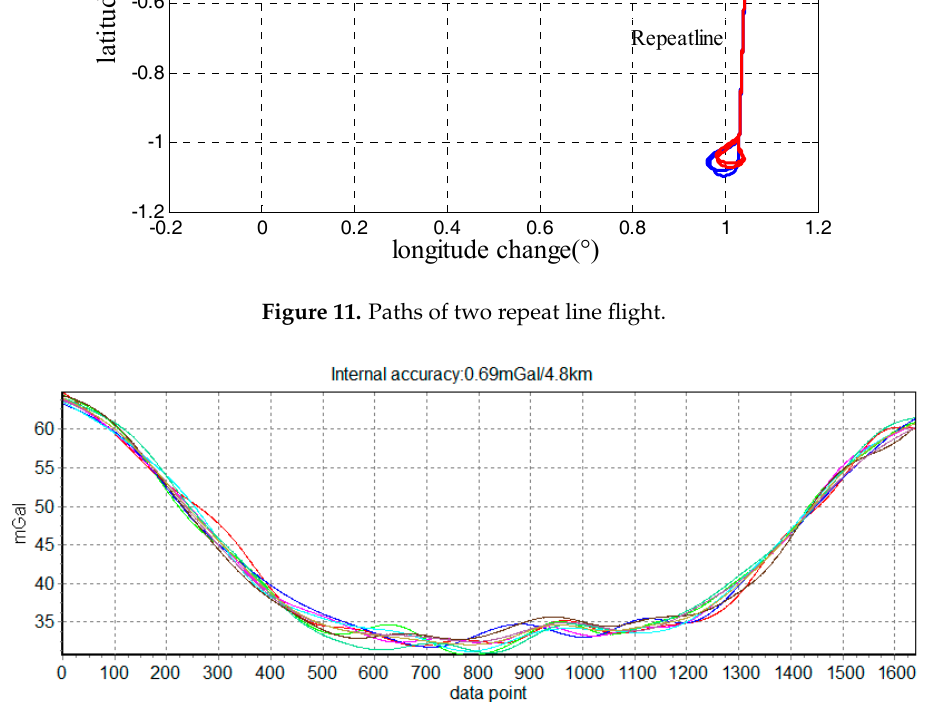
Figure 12. Measurement result of 8 repeat lines.